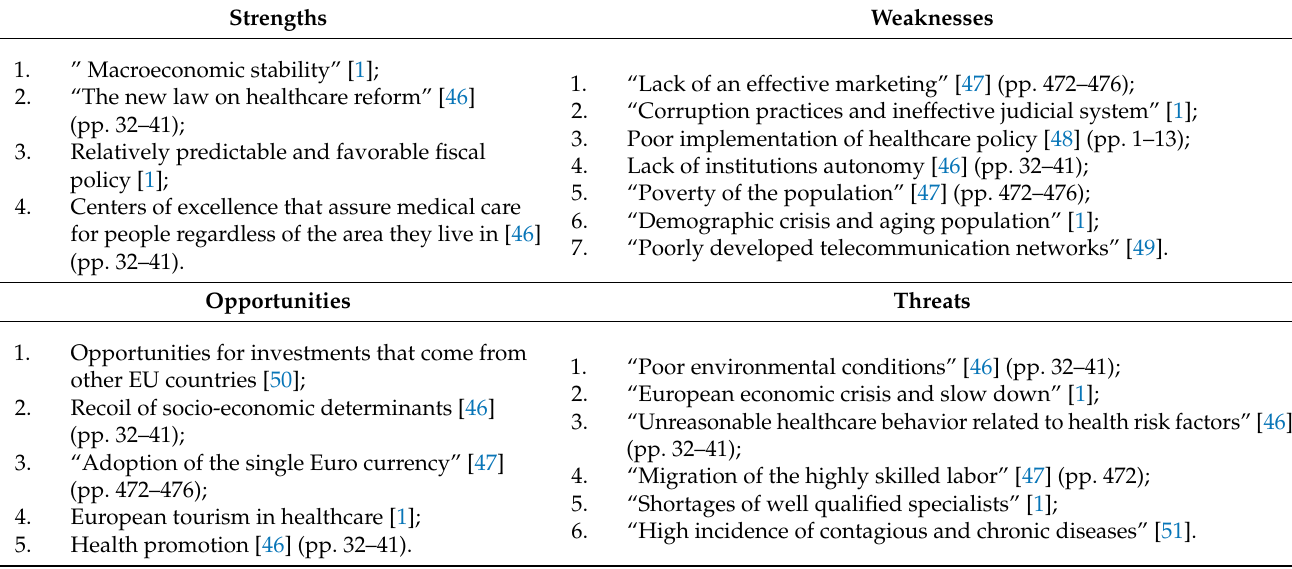
Table 3. SWOT analysis of healthcare system in